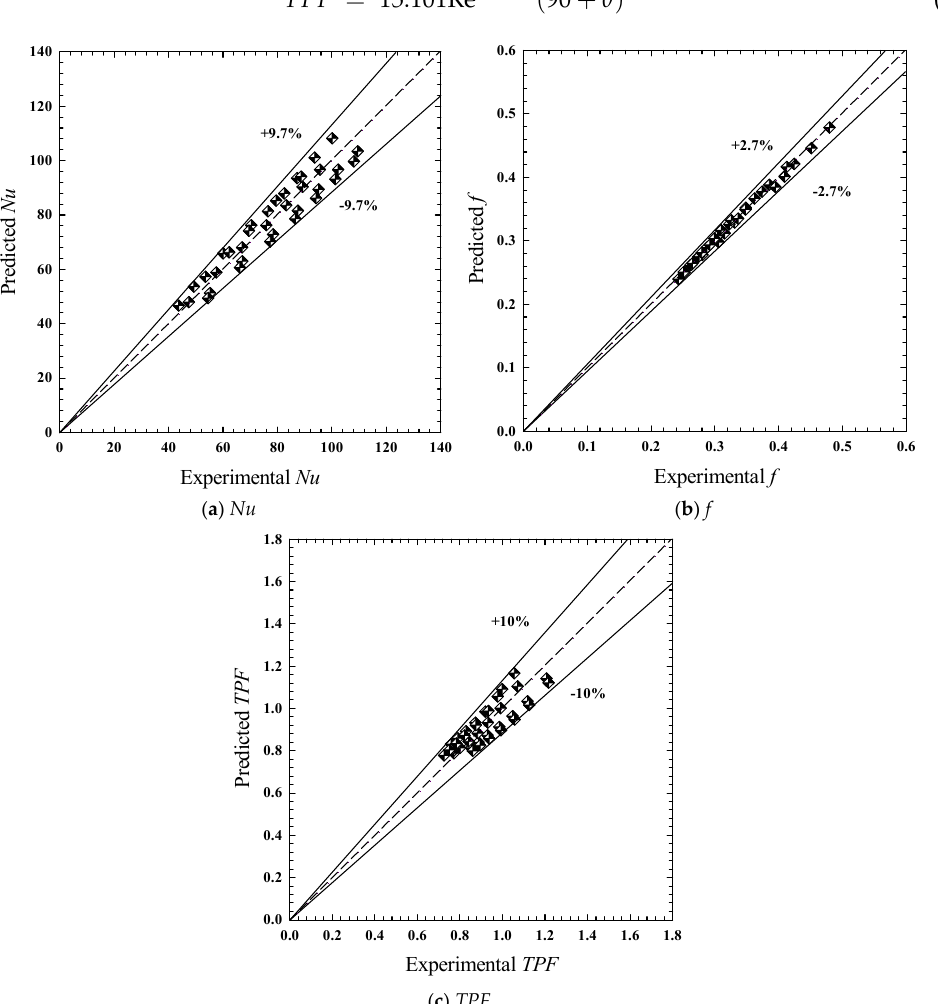
Figure 10. Experimental data prediction